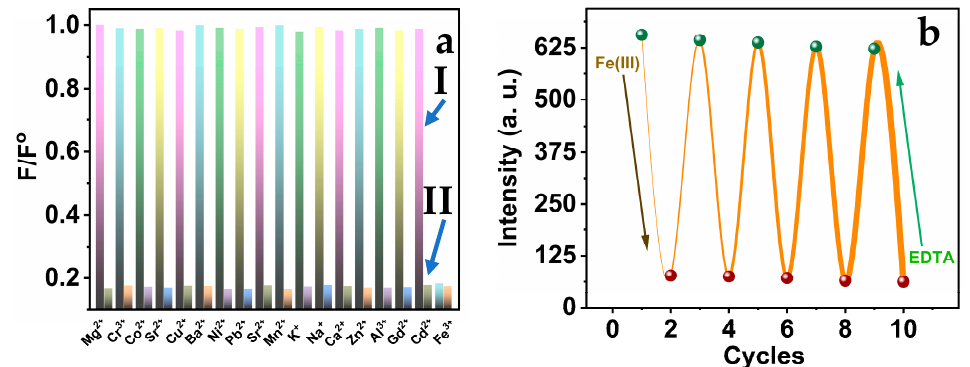
Figure 7. ( a ) Tryp-AgNCs fluorescence intensities in the presence of (I) each different metal ions and (II) each different metal ions and Fe(III); ( b ) The recovery effect of EDTA solution on Tryp-AgNCs fluorescence.